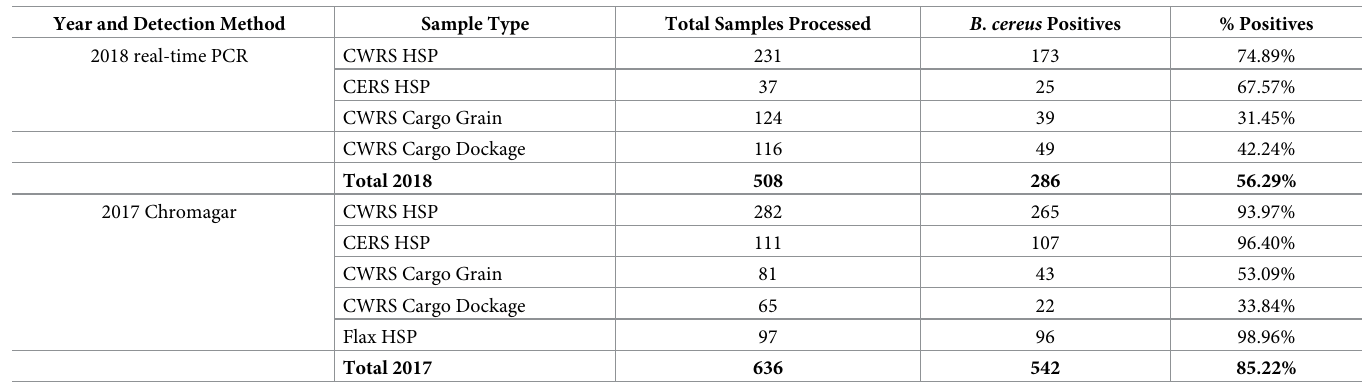
Samples included Canada Western Red Spring (CWRS) and Canada Eastern Red Spring (CERS) wheat, dockage (any material intermixed with grain, other than